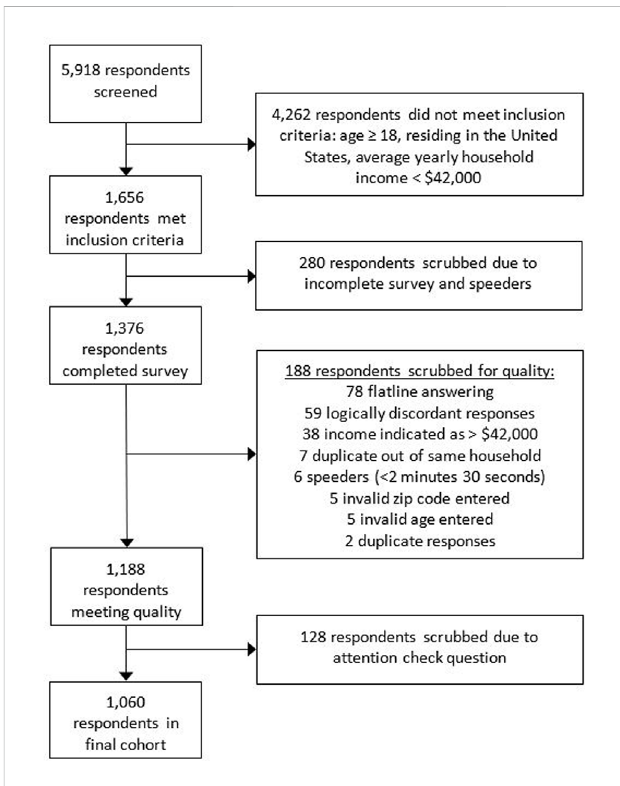
FIGURE 1 Nationwide survey respondent fl ow chart and quality control details for exclusion of respondents. The reasons for respondents scrubbed for quality will total to more than 188 as some respondents were scrubbed for multiple